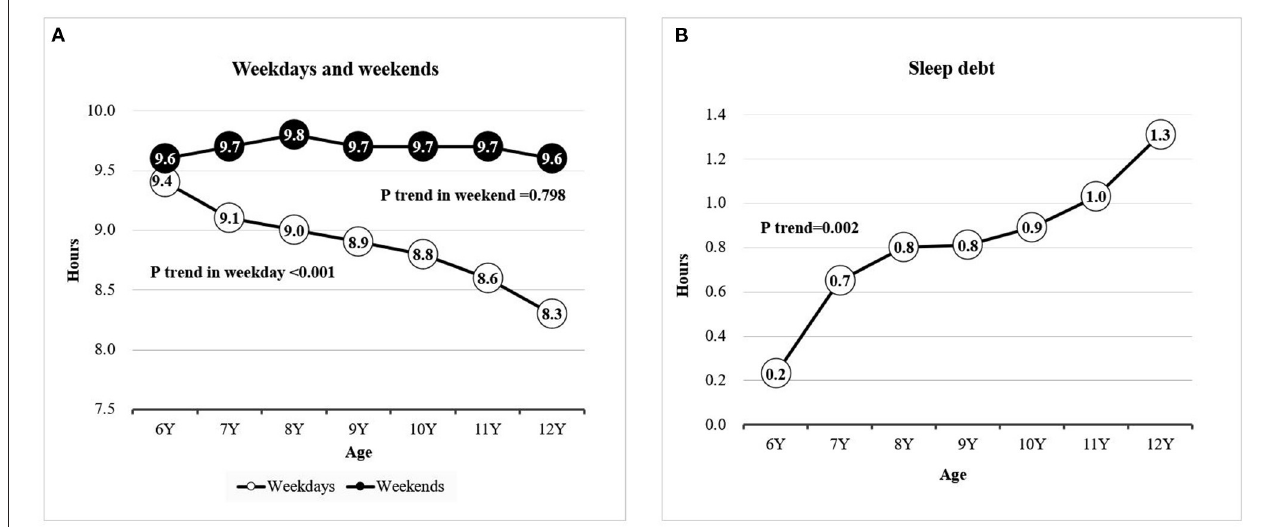
FIGURE 2 | Mean sleep duration by age. (A) Sleep duration on weekdays and on weekends; (B) mean sleep debt.